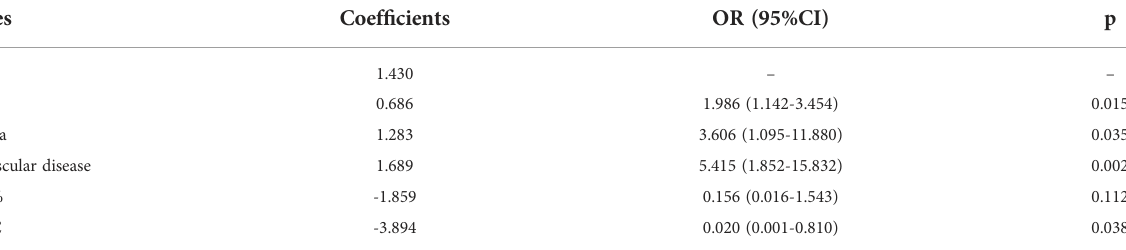
TABLE 2 Risk factors and their parameters of the logistic